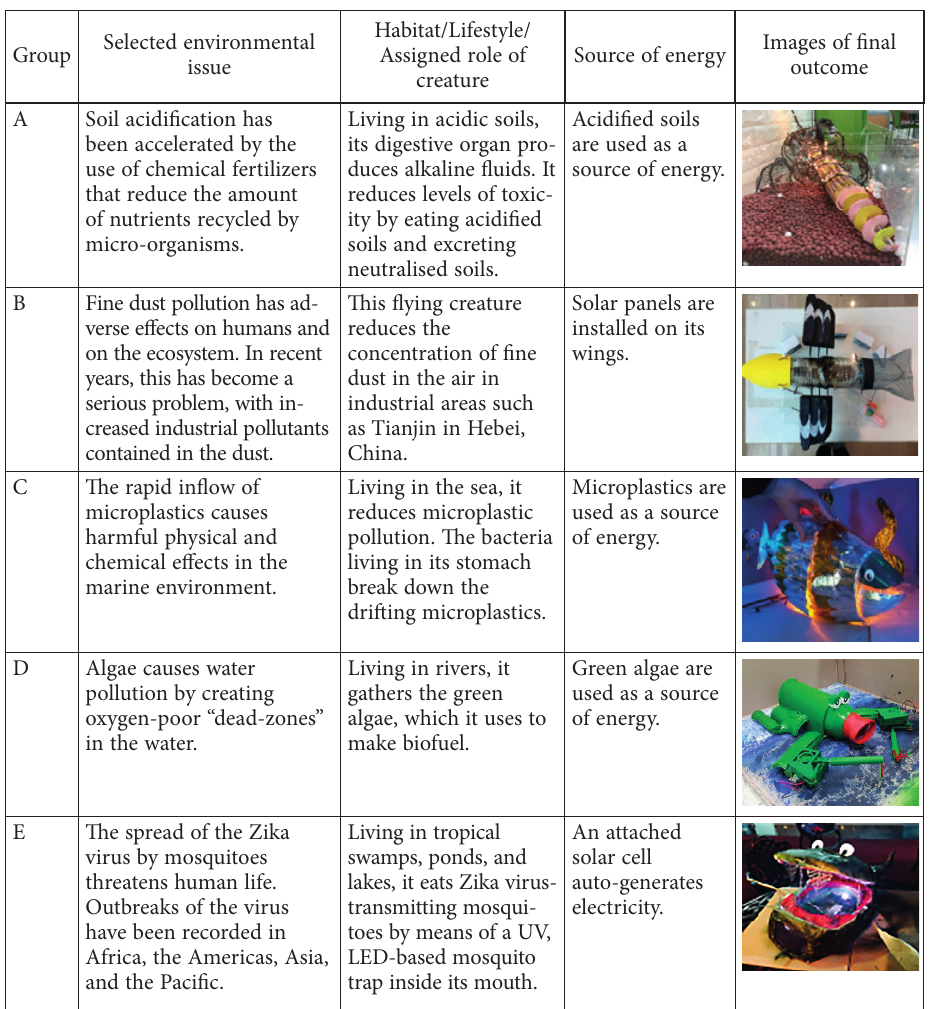
Table 4. Final projects displayed in the exhibition hall (source: created by